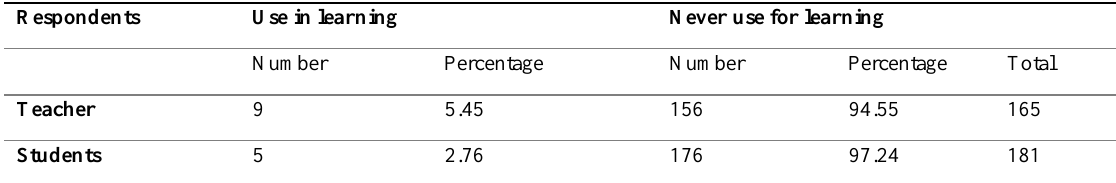
Table 7: Those who have internet access, use in learning